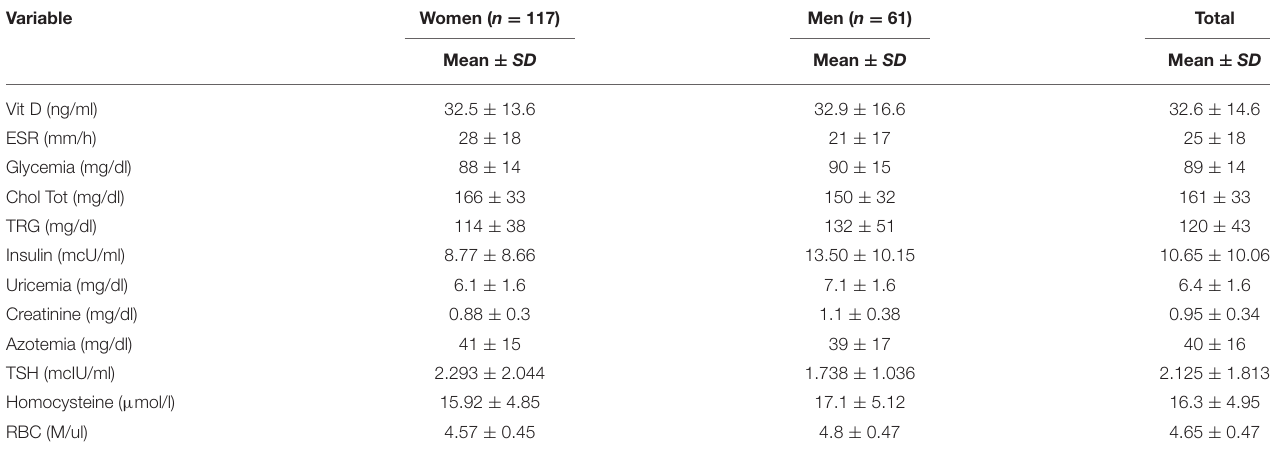
TABLE 2 | Baseline biochemical characteristics.